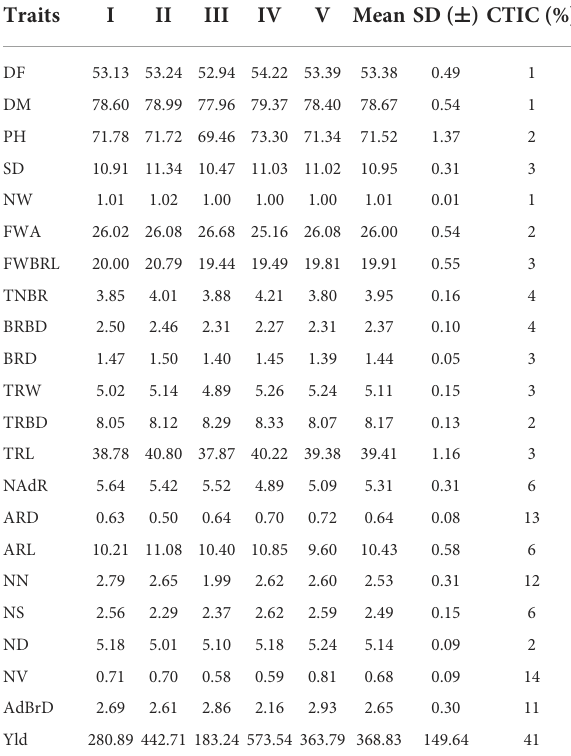
TABLE 6 Mean performance of cowpea genotypes and contribution of traits for grouping the genotypes into five distinct clusters. Clusters